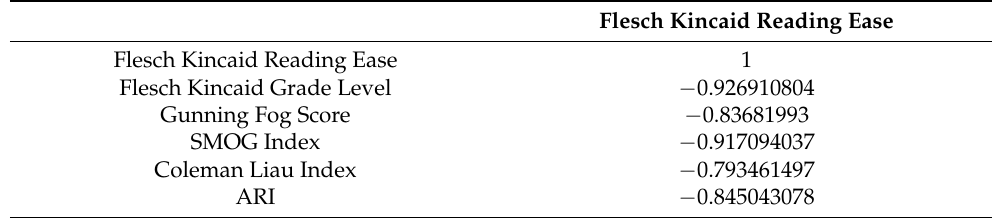
Table 2. Correlation between FKRE and the formulas.